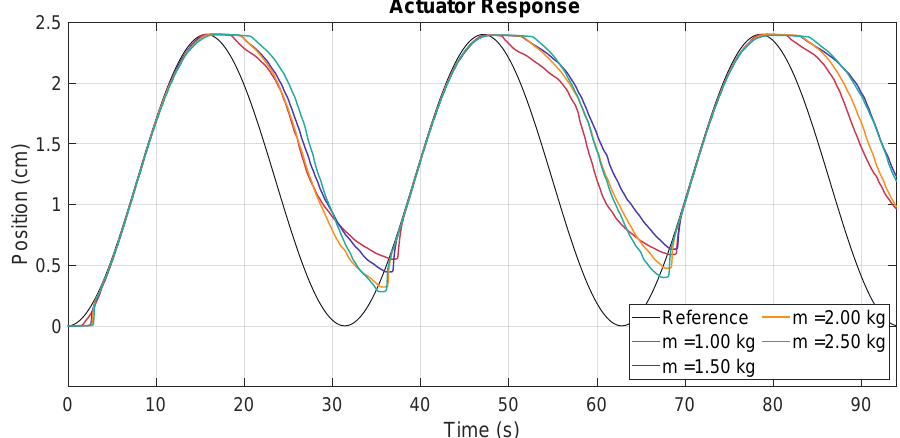
Figure 10. Comparison of the actuator’s responses with different